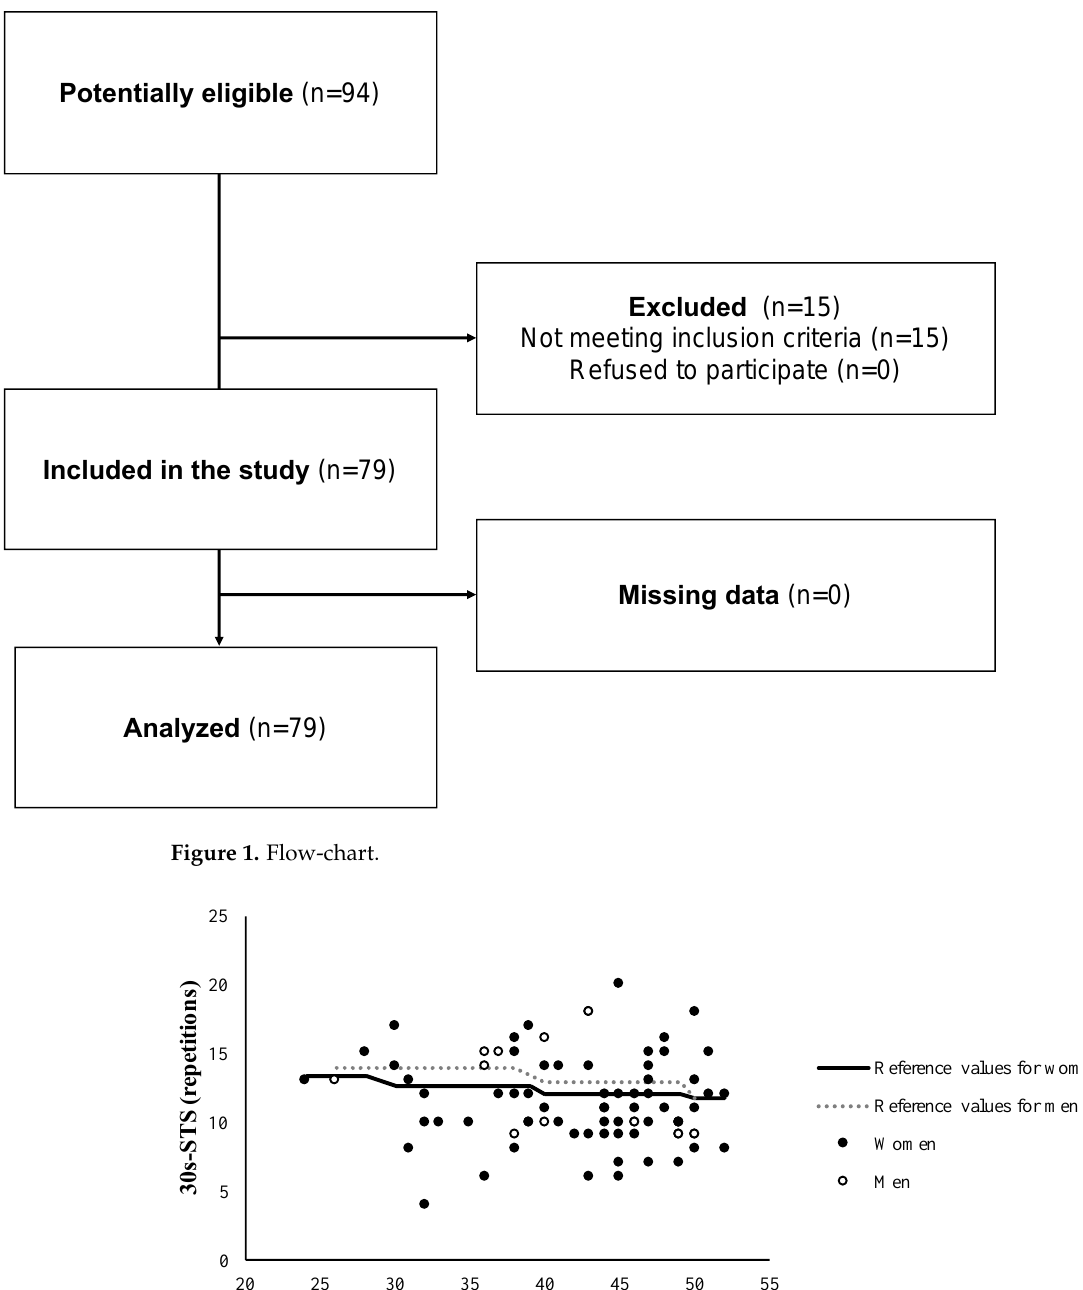
Figure 2. Functional performance of women and men long COVID patients vs. sex- and age-specific reference values. The reference values correspond to the sex- and age-specific zenith curves reported by Warden et al. [34] (i.e., the lower limit of the standard deviation of the mean number of repetitions in 30 s-sit-to-stand).